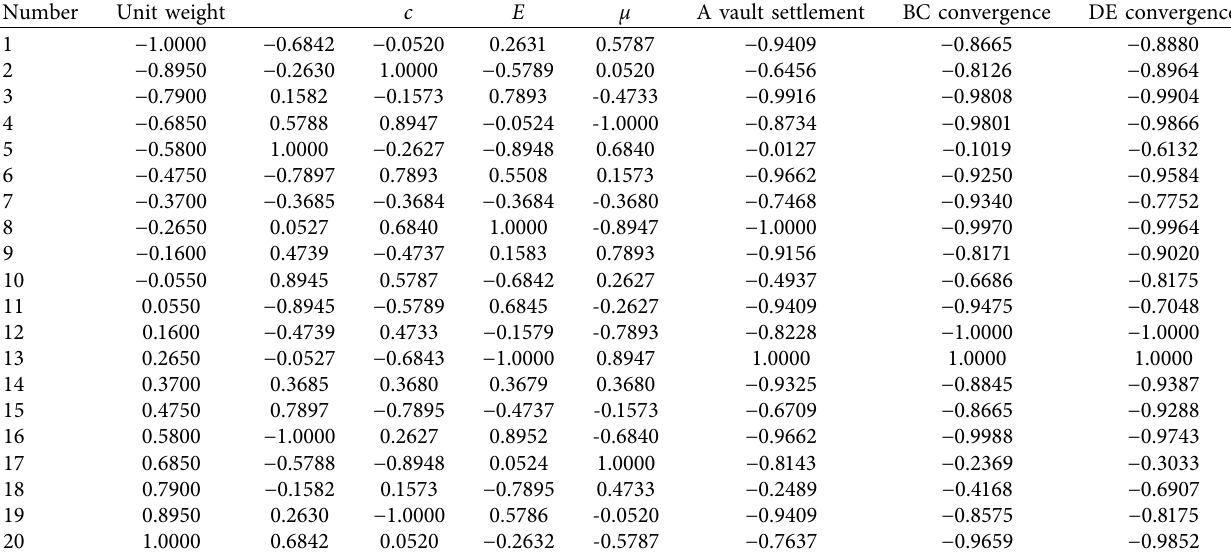
Table 4: The normalized training dataset.